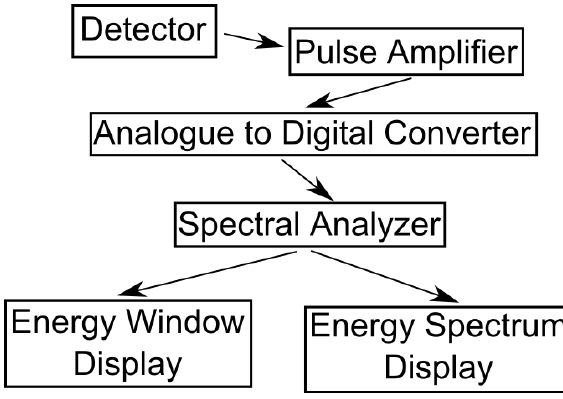
Figure 2. Block diagram showing the main sections which are common to most gamma-ray spectrometers. Figure adapted from International Atomic Energy Agency (IAEA) 2003 report